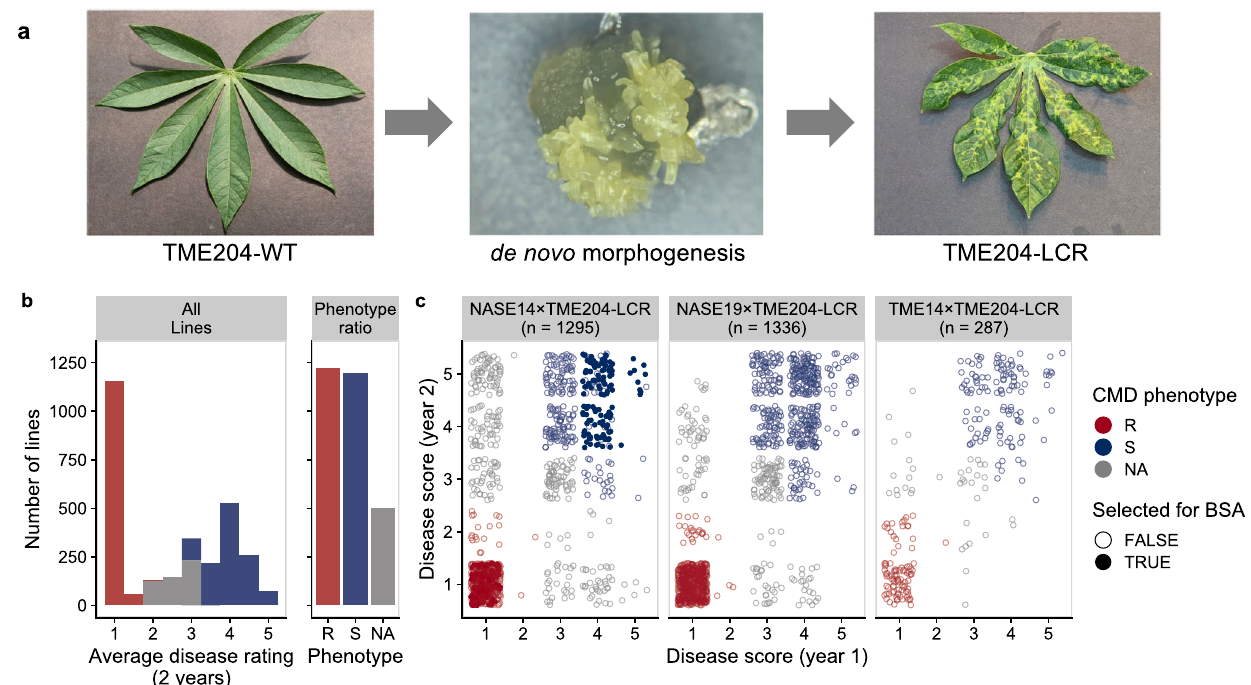
Fig. 1 CMD2 type cassava varieties lose resistance upon de novo morphogenesis. a Left — TME204-WT CMD2-type plants challenged with cassava mosaic geminivirus remains symptom free. Middle – embryogenic structures arise from tissue culture-induced de novo morphogenesis. Right — Regenerated plant shows classic mosaic symptoms after virus challenge. b F1 populations derived from heterozygous resistant parents (NASE14, NASE19, TME14) crossed with susceptible loss-of-CMD2-resistance (LCR) line. Plants were grown and phenotyped in the fi eld in Uganda and scored for disease over two years on a 1-5 disease score. The disease rating distribution across all populations segregates at 1:1 ( χ 2 p -value = 0.5263; R = 1291, S = 1259). c In the NASE14xTME204-LCR population, 125 resistant and 125 susceptible lines with consistent phenotypes over the 2 years were selected for bulk segregant analysis (BSA) mapping (solid